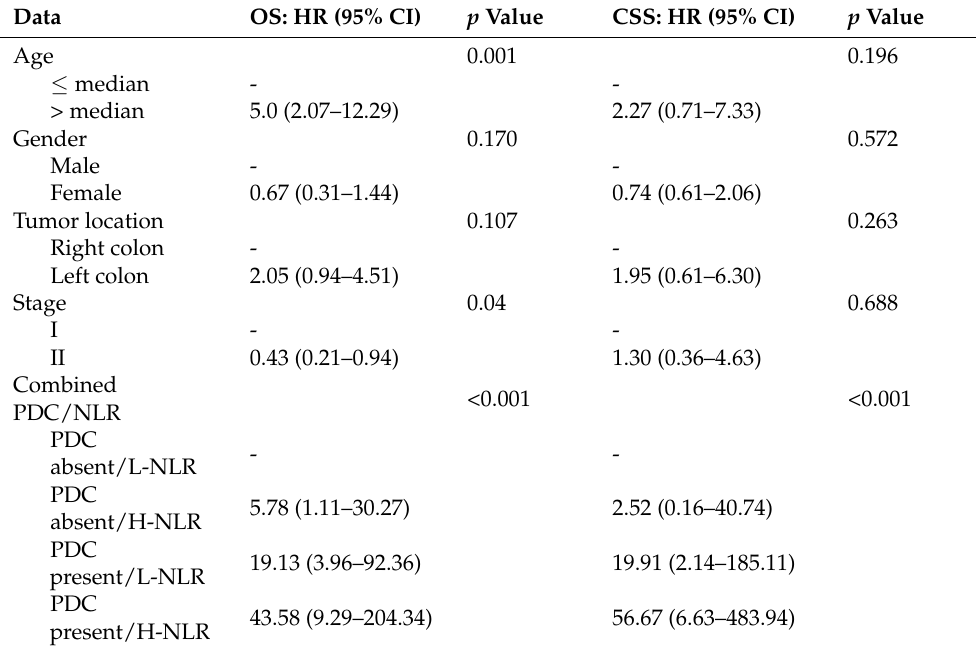
Table 4. Multivariable analysis for overall- and cancer-specific survival conducted with the combination